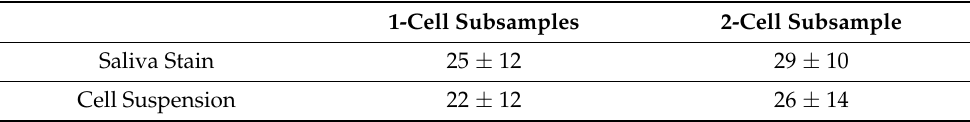
Figure 1. Cell suspensions created in various suspension mediums. 1× PBS (red), nuclease-free water (blue), and TE − 4 (green). 1C = 1 cell, 2C = 2 cells, n = number of samples analyzed. Table 1. Allele recovery of 1- and 2-cell subsamples collected after 6 months from either a cell suspension or a saliva stain.